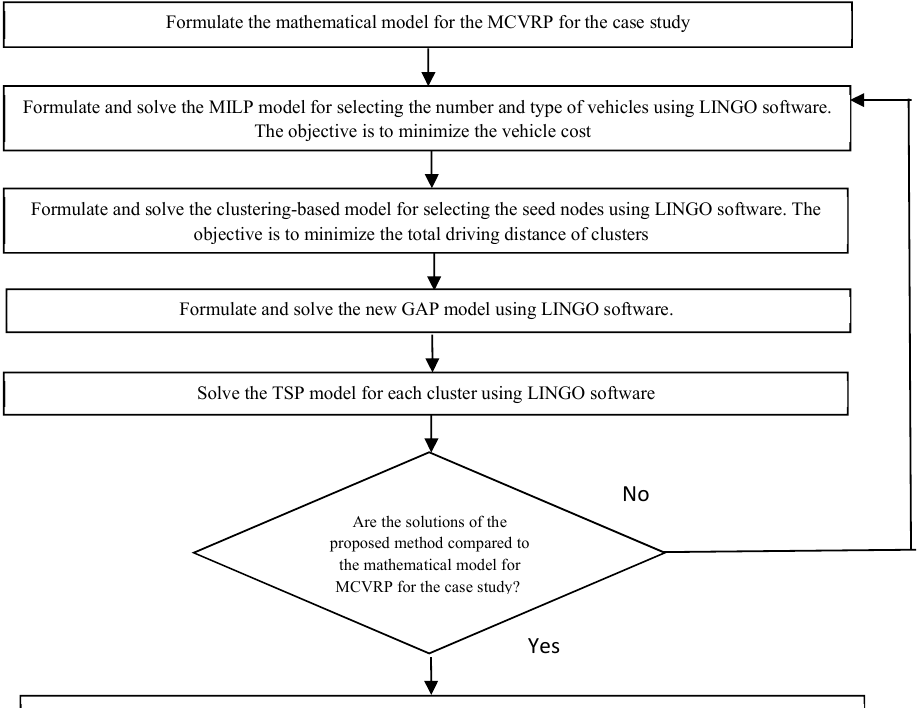
Fig.2. The study framework